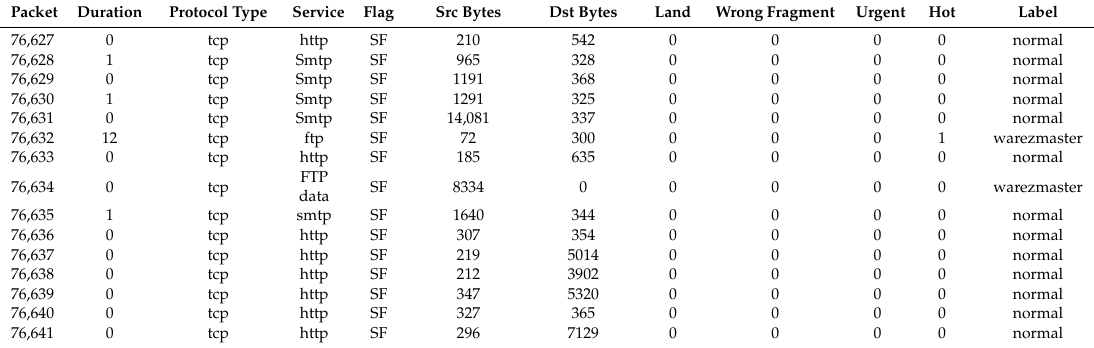
Table 1. A sample of data log in which a warezmaster attack was interlaced by a normal packet. Packet Duration